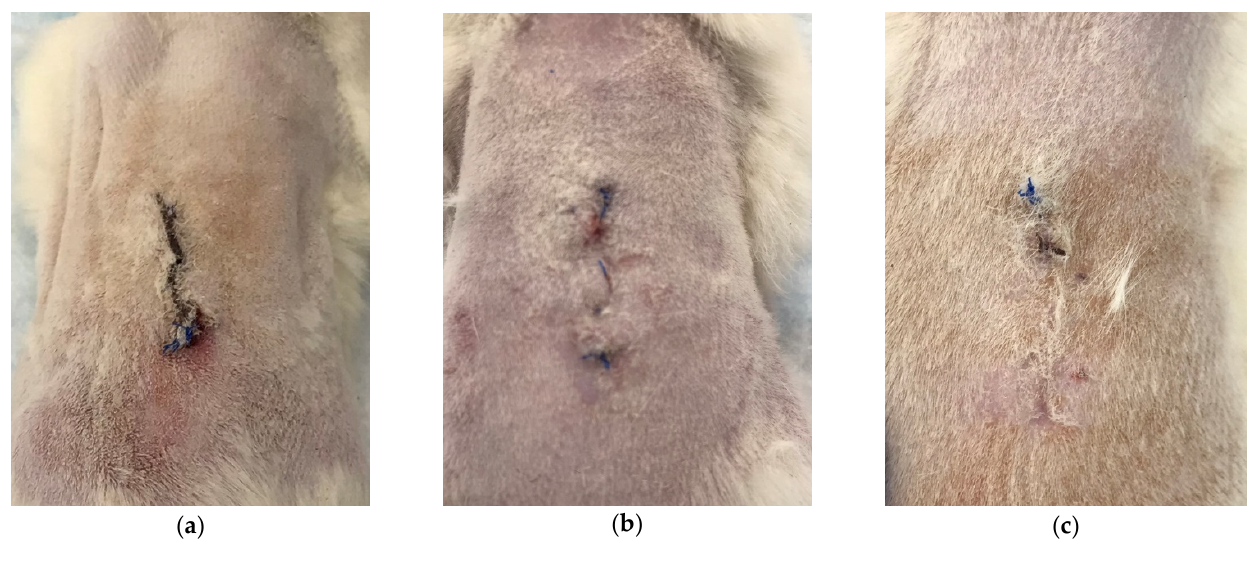
Figure 2. Postoperative suture appearance on day 7 ( a ), day 14 ( b ), day 21 ( c )—representative photographs.